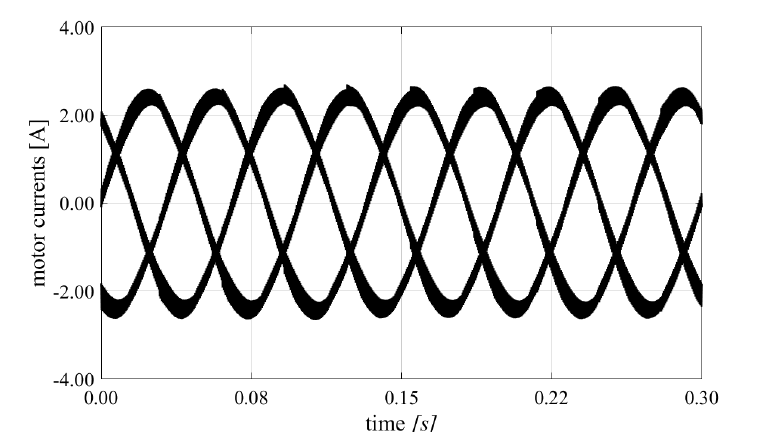
Figure 5. Numerical result: motor currents achieved with the proposed SVM based on Equation (22), when m = 0.27, v ∗ = v ∗ = 200 V, and T l = 3.5 C1 C2